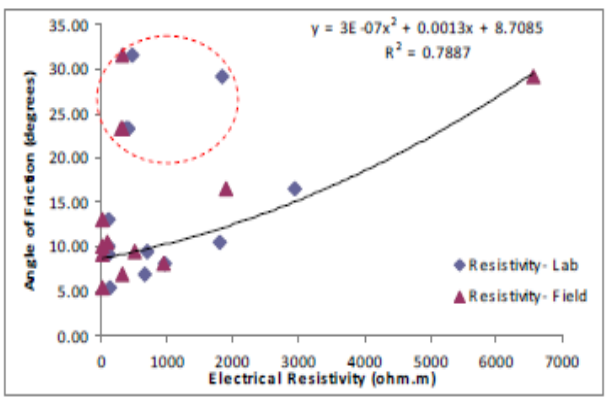
Fig. 5. Relationship between ER and the angle of friction